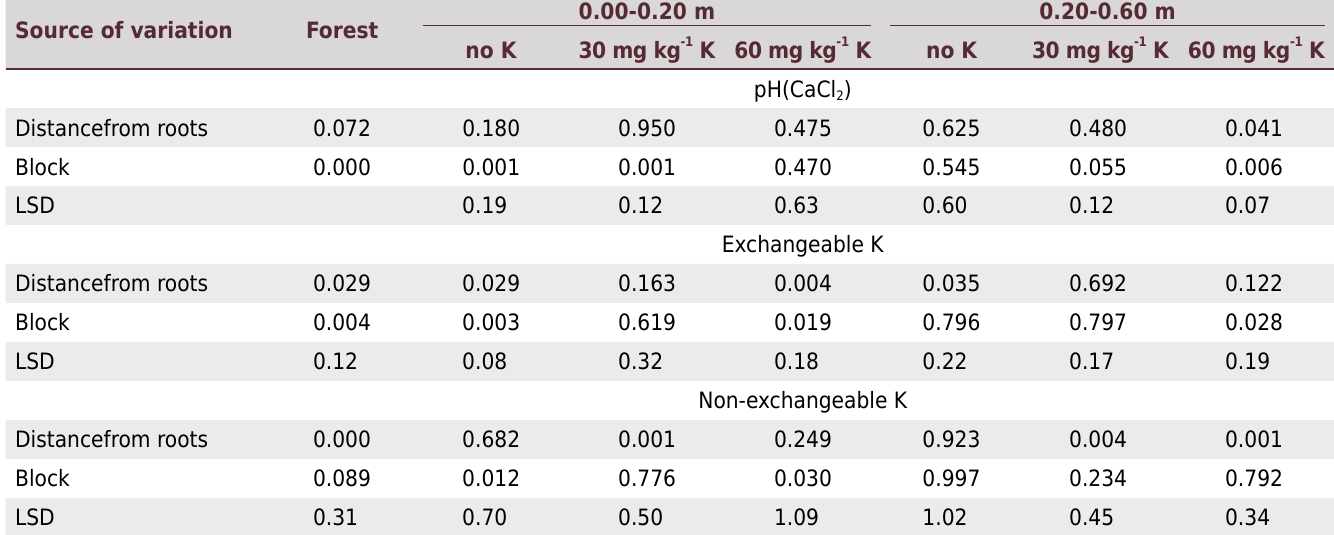
Table 2. Summary of the ANOVA results (p value) and LSD for pH(CaCl 2 ), exchangeable and non-exchangeable K as affected by the distance from the roots of U. ruziziensis in each soil treatment Source of